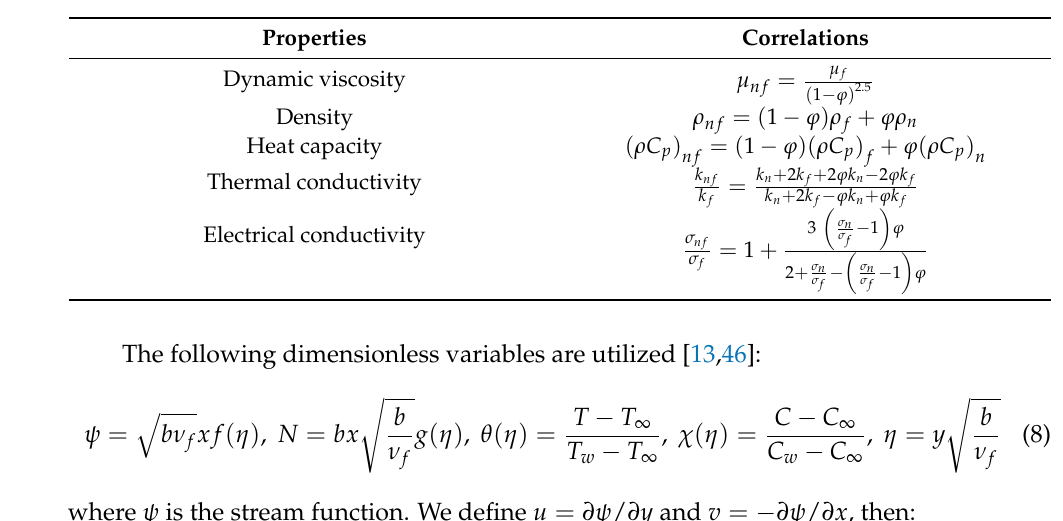
Table 2. Thermophysical properties of